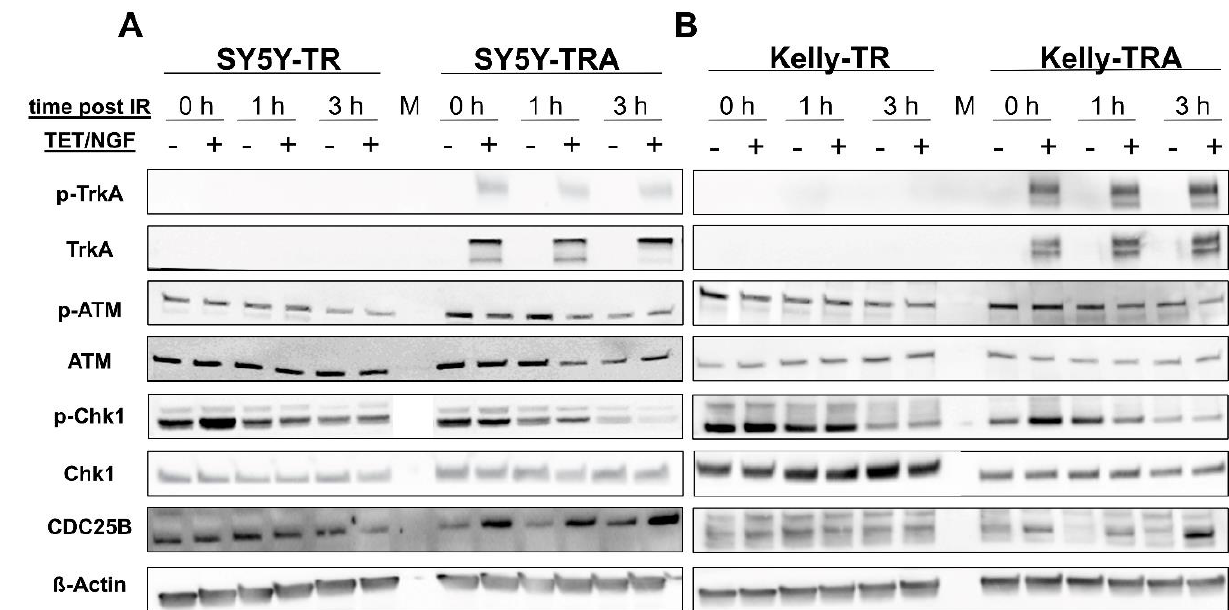
Figure 5. The ATM/ATR DNA-damage signaling pathway is inhibited by TrkA/NTRK1 activation in SY5Y and Kelly cells. Representative Western blots showing expression and phosphorylation of TrkA/NTRK1, ATM, Chk1, and CDC25B. Expression of ß-Actin served as loading control. Original Western Blot data are provided as Supplementary Figure S8 ( A ) SY5Y and ( B ) Kelly TR and TRA cells. Cell were exposed to irradiation with 1 Gy and analyzed at time points thereafter as indicated.